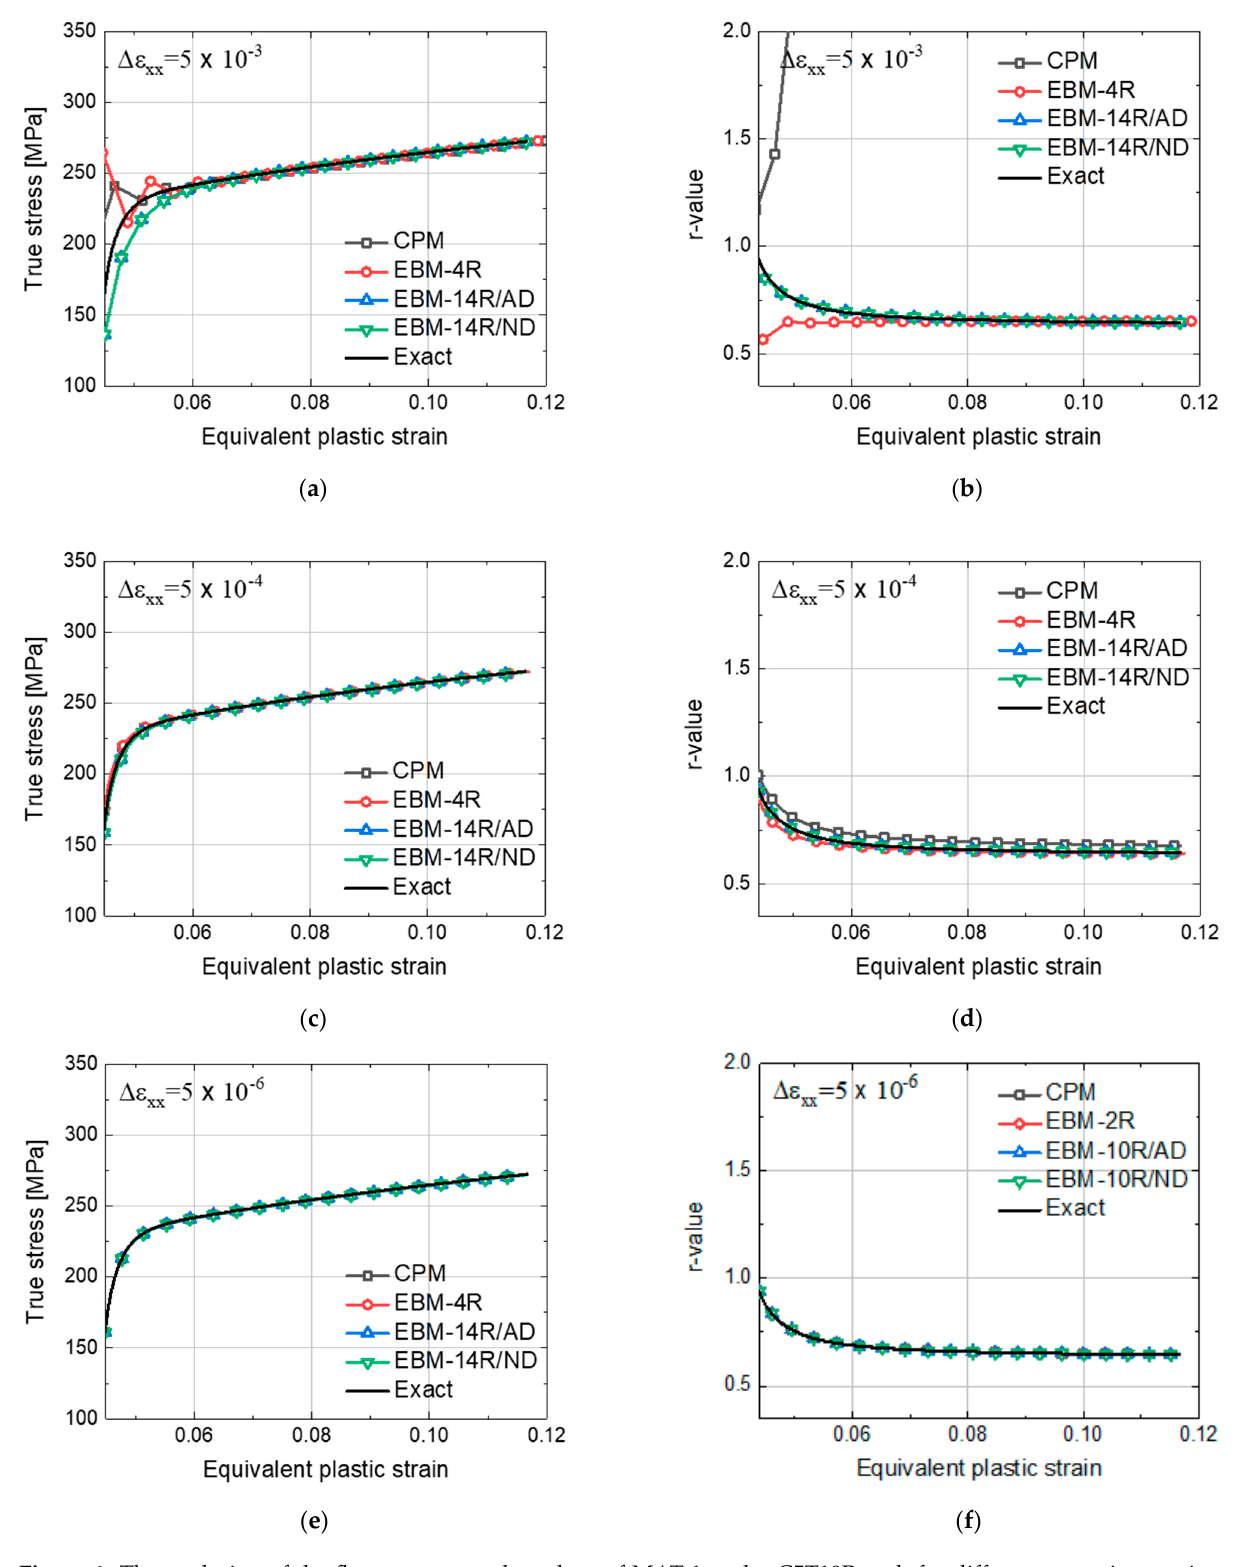
Figure 6. The evolution of the flow stresses and r − values of MAT 1 under C5T10R path for different stress integration algorithms with strain increments: ( a , b ) ∆ ε xx = 5 × 10 − 3 , ( c , d ) ∆ ε xx = 5 × 10 − 4 and ( e , f ) ∆ ε xx = 5 × 10 − 6